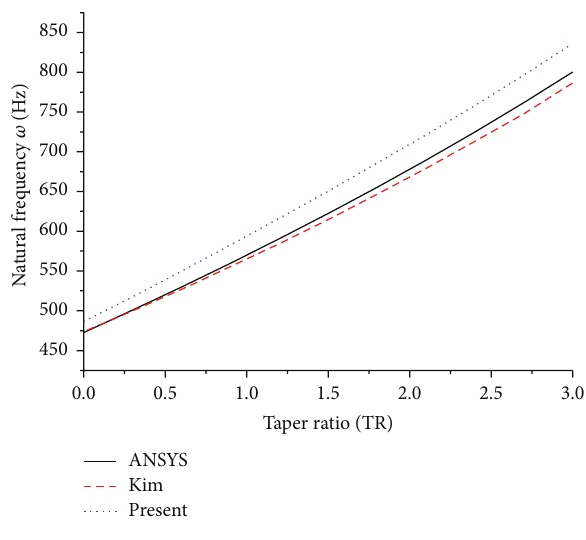
Figure 2: Changes comparison with TR ( Ω = 0 rad/s).